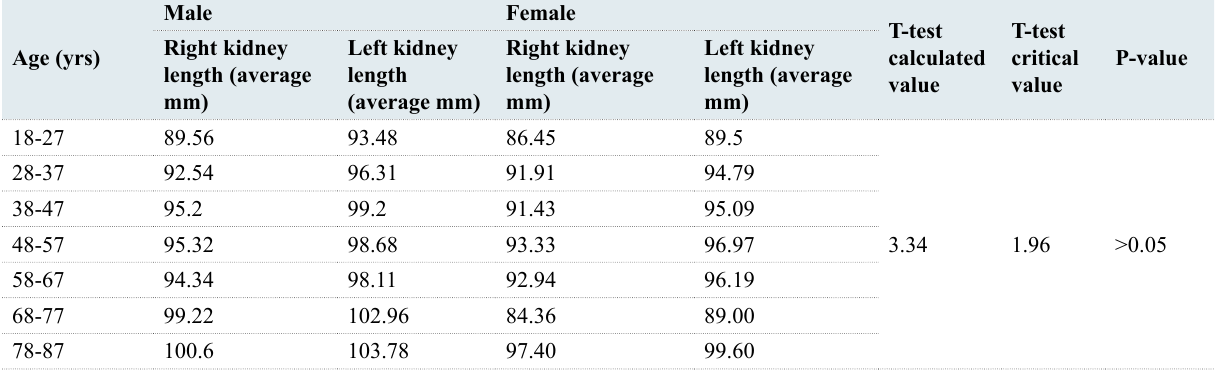
Left kidney length (average mm)